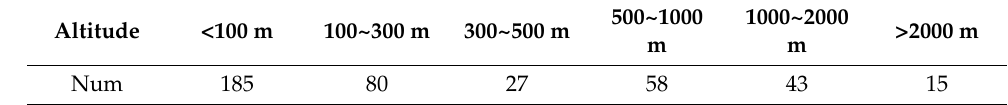
Table 6. Number of IGS stations (Num) at different altitudes.